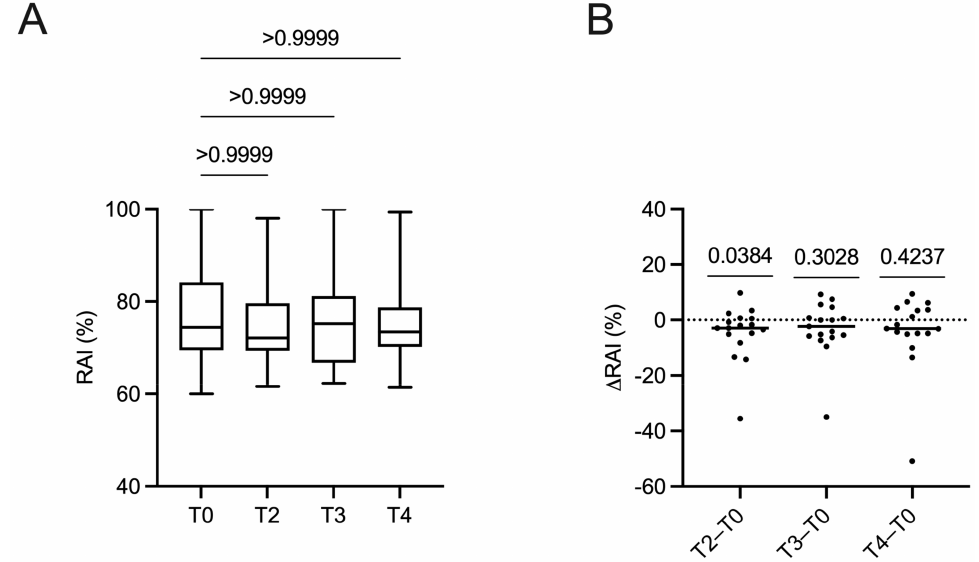
Figure 2. Avidity of anti-Epstein–Barr virus capsid antigen (CA) IgG expressed as relative affinity index (RAI) in 17 relapsing–remitting multiple sclerosis patients treated with dimethyl fumarate. Time points refer to pre-treatment (T0) and after 1 (T2), 3 (T3) and 6 (T4) months of therapy. Urea was used to measure antibody avidity. For each patient, the RAI, expressed as a percentage, was calculated through the ratio between the optical density (OD) of the sample treated with urea, multiplied by 100, and the OD of the same sample without urea treatment. The Friedman test and Dunn’s post hoc test for repeated measures were used to compare RAI at all time points (Panel A ). The RAI value of the first sample taken at T0 was subtracted from the further time points, calculating ∆ RAI values (T2 − T0, T3 − T0 and T4 − T0). The ∆ RAI values were compared at all time points with the Wilcoxon Signed Rank Test (Panel B